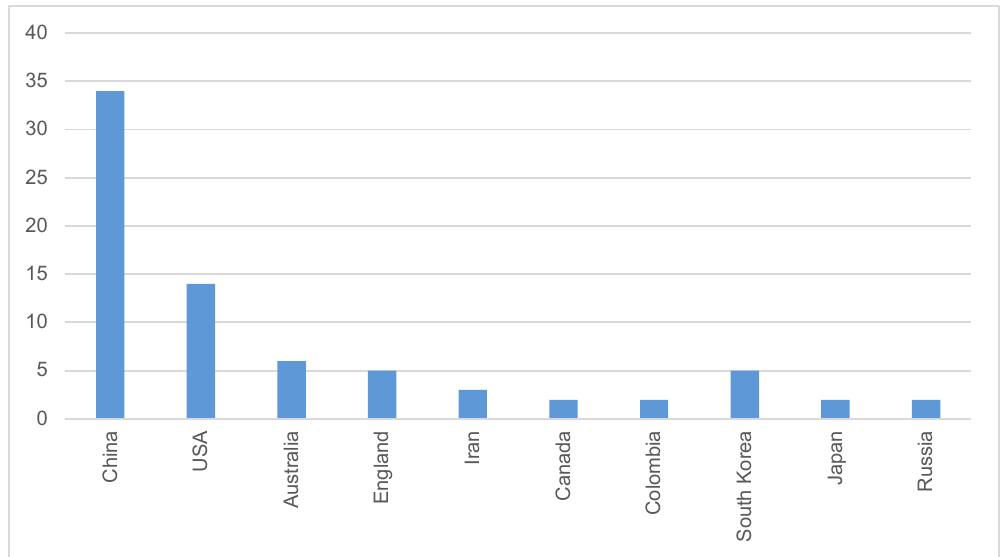
Fig. 7. Countries with the highest number of publications related to system dynamics. Source: created by the author based on data from Clarivate